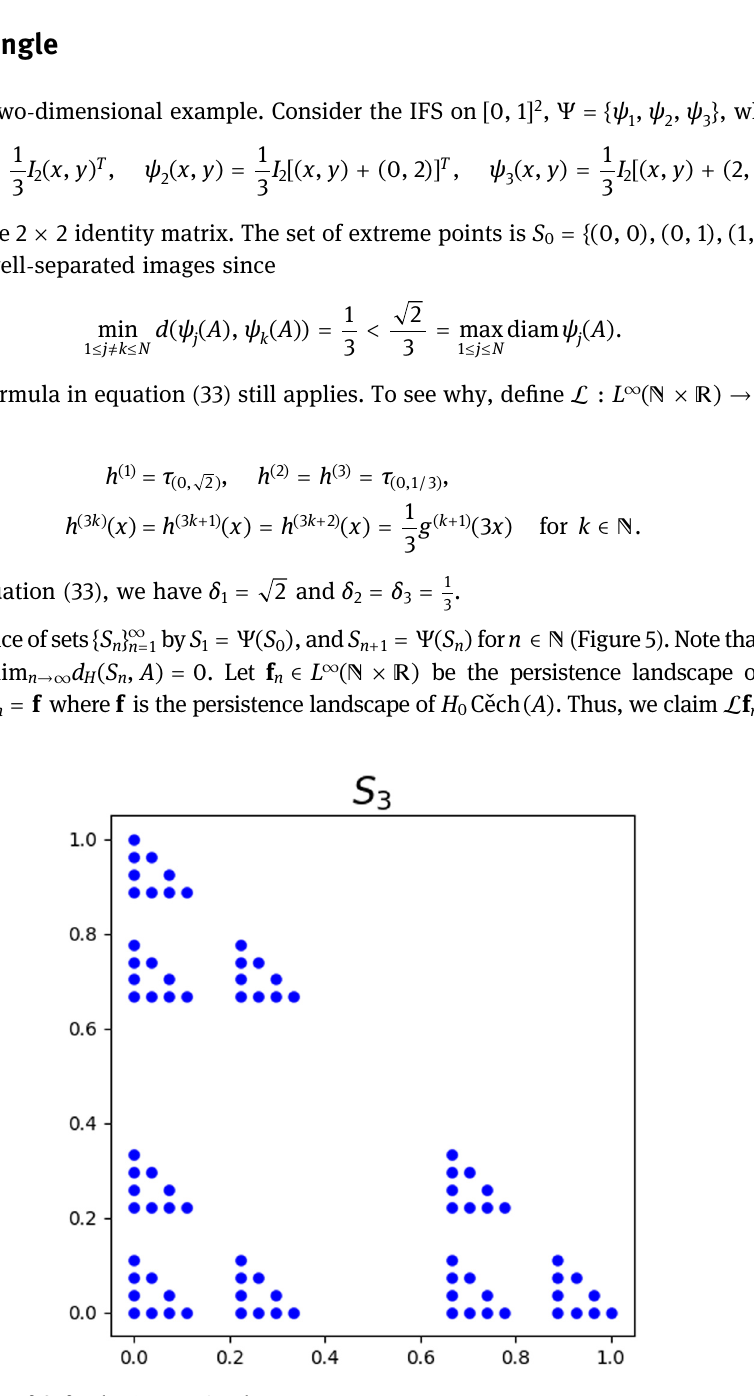
Figure 5: An illustration of S 3 for the Cantor